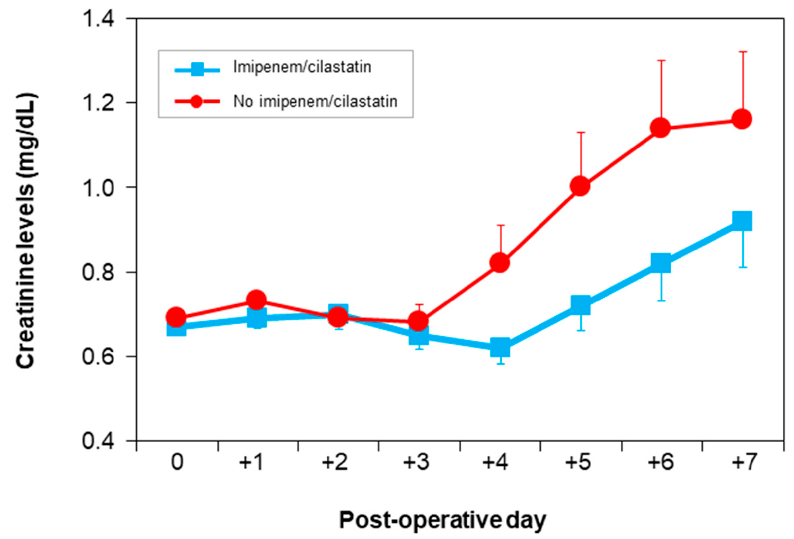
Figure 2. Change in serum creatinine levels from baseline up to day 7 in both groups. Detailed day-to-day analysis revealed significant differences in creatinine levels on day 4 (0.62 ± 0.33 vs. 0.82 ± 0.78 mg/dL; p = 0.04) and differences that were at the limit of statistical significance on day 5 (0.72 ± 0.5 vs. 1 ± 1 mg/dL; p = 0.06) and on day 6 (0.82 ± 0.67 vs. 1.14 ± 1.2; p = 0.09) (Figure 2 and Table 2).